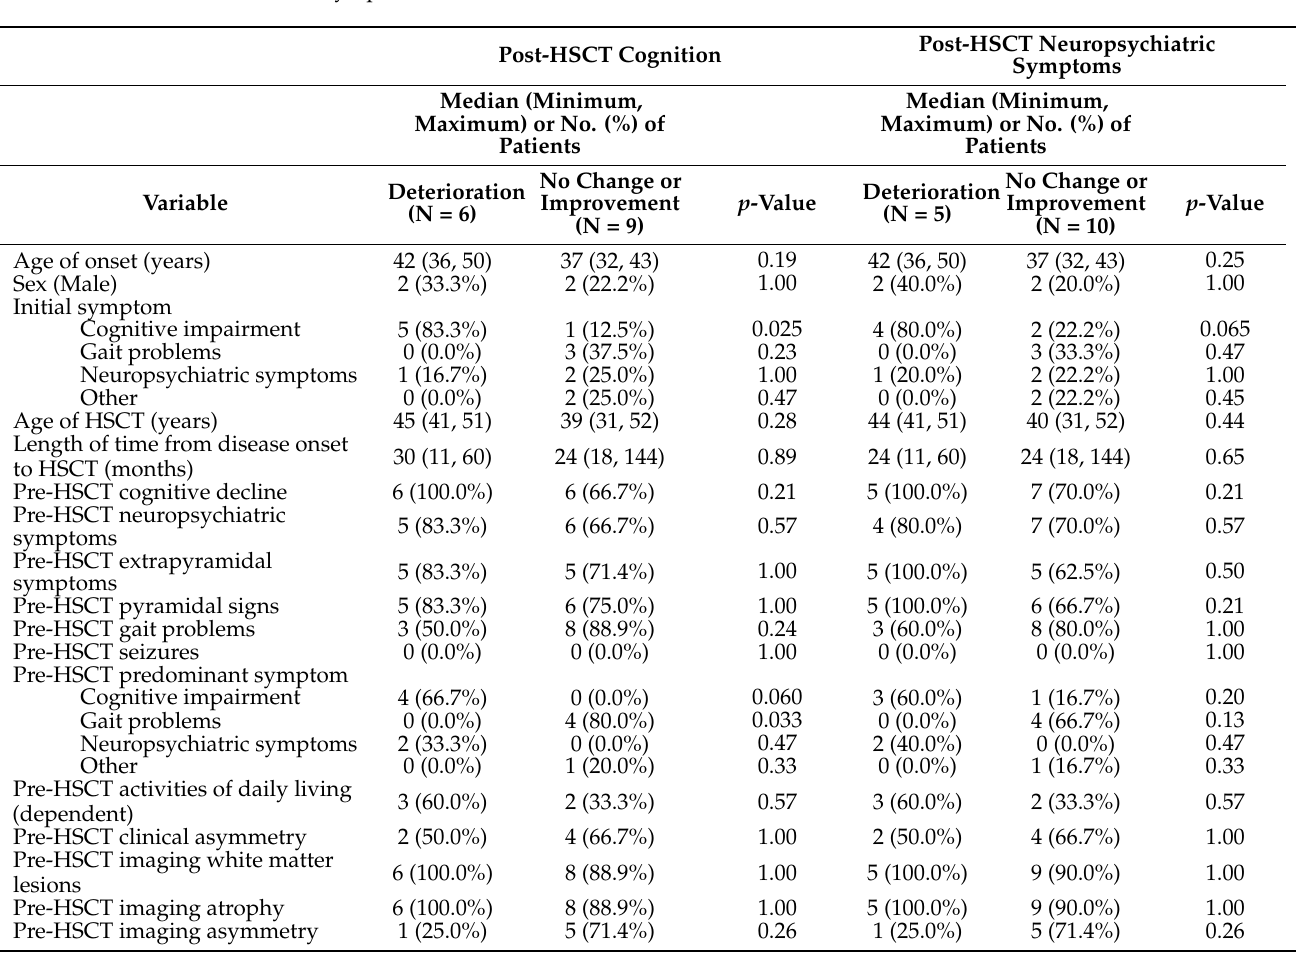
Table 4. Associations of patient characteristics with post-HSCT cognition and neuropsychiatric symptoms.